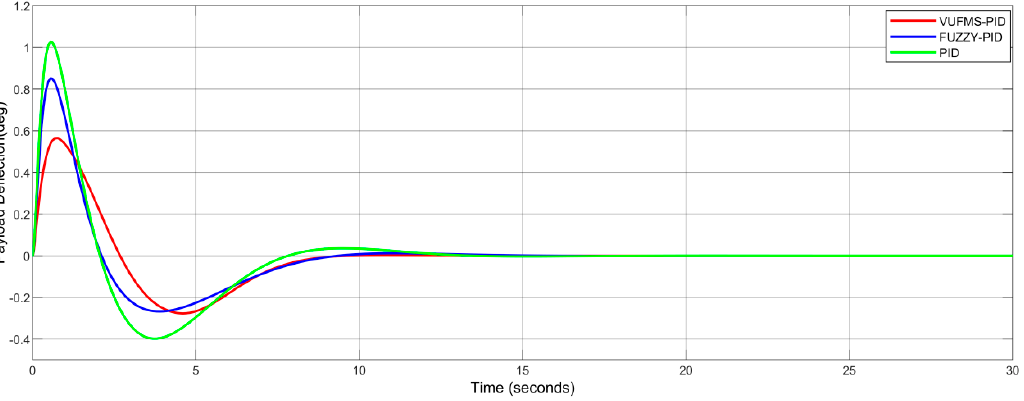
Figure 12. Trolley’s position using VUFMS-PID, FUZZY-PID and PID controller under working condition 3. Table 6. Performances obtained using VUFMS-PID, FUZZY-PID, and PID controller under work- ing condition 1.